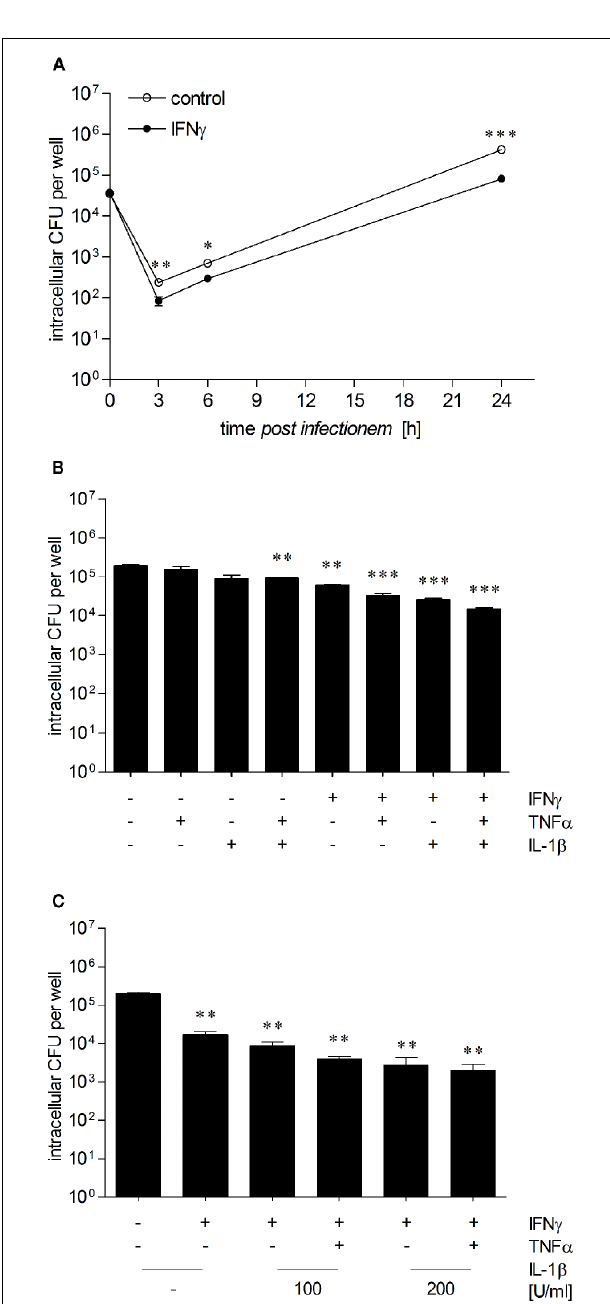
FIGURE 4 | Proinflammatory cytokines increase anti- B. pseudomallei activity of hepatocytes. (A) Intracellular survival of B. pseudomallei E8 in unstimulated (opened circles) and IFN γ -stimulated (500ng/ml; closed circles) HepG2 cells infected with an MOI of 36:1. (B) Intracellular survival of B. pseudomallei E8 24h after infection (MOI 37:1) of HepG2 cells pretreated with IFN γ (500ng/ml), IL-1 β (50U/ml), orTNF α (10ng/ml) alone or in combination. (C) Intracellular survival of B. pseudomallei E8 24h after infection (MOI 36:1) of HepG2 cells activated with IFN γ alone (500ng/ml) or in combination with IL-1 β (100–200U/ml) andTNF α (10ng/ml). Data are presented as mean with SEM of triplicate determinations. One representative experiment out of three independent experiments is shown. Statistical analyses were performed using a Student’s t -test (* p < 0.05, ** p < 0.01, *** p <